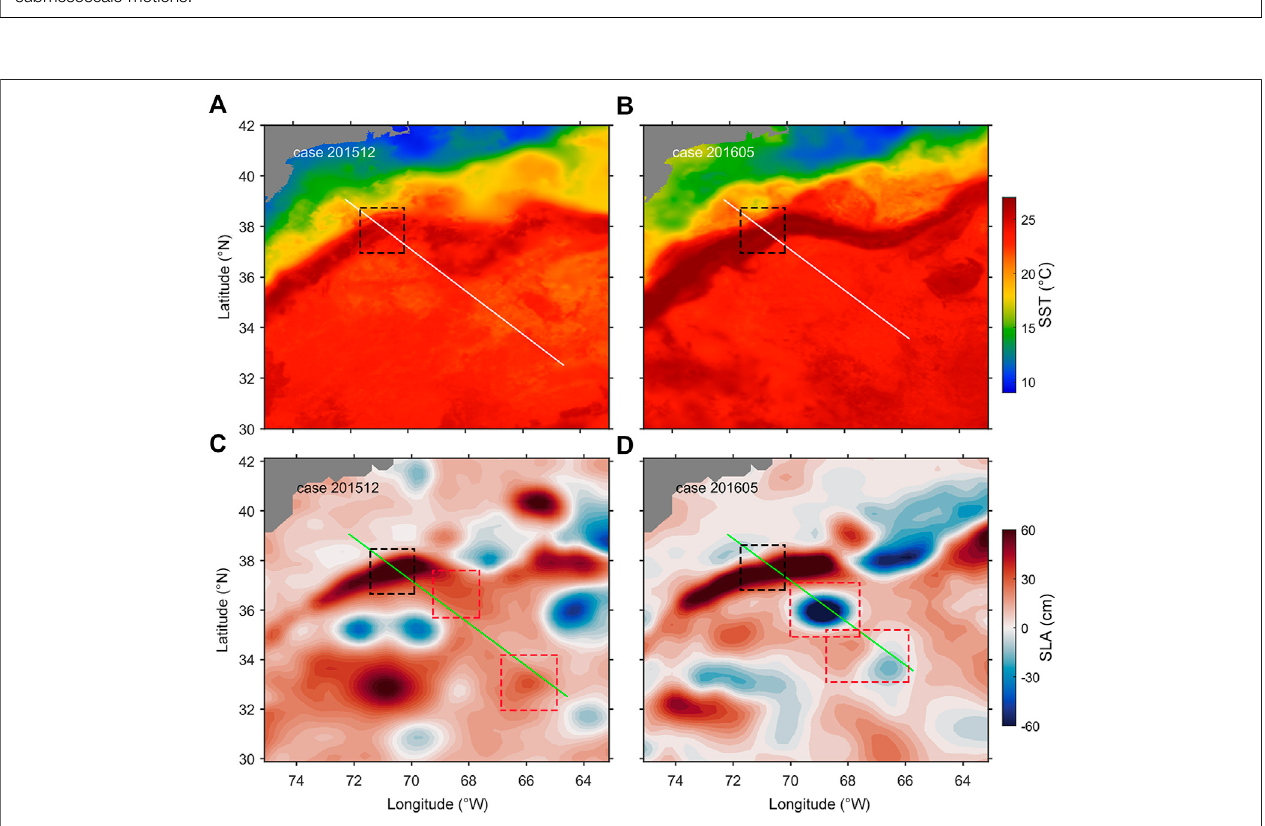
FIGURE6| MapsofSST( ° C)andSLA(cm)ofcase201512 (A,C) andcase201605 (B,D) .Thewhitelinesin (A,B) andthegreenlinesin (C,D) arethevehicletracks. TheblackdashedboxesmarktheGulfStream,andthereddashedboxesmarkmesoscaleeddiesthatgenerate/in fl uencesubmesoscalemotions,consistentwiththose in Figures2 , 5 .TheSSTdataarefrom theGroupforHighResolutionSea SurfaceTemperature(GHRSST,https://sealevel.nasa.gov/missions/ghrsst), and thesealevel anomaly data are produced by SSALTO/DUACS and distributed by AVISO (https://www.aviso.altimetry.fr/en/home.html).